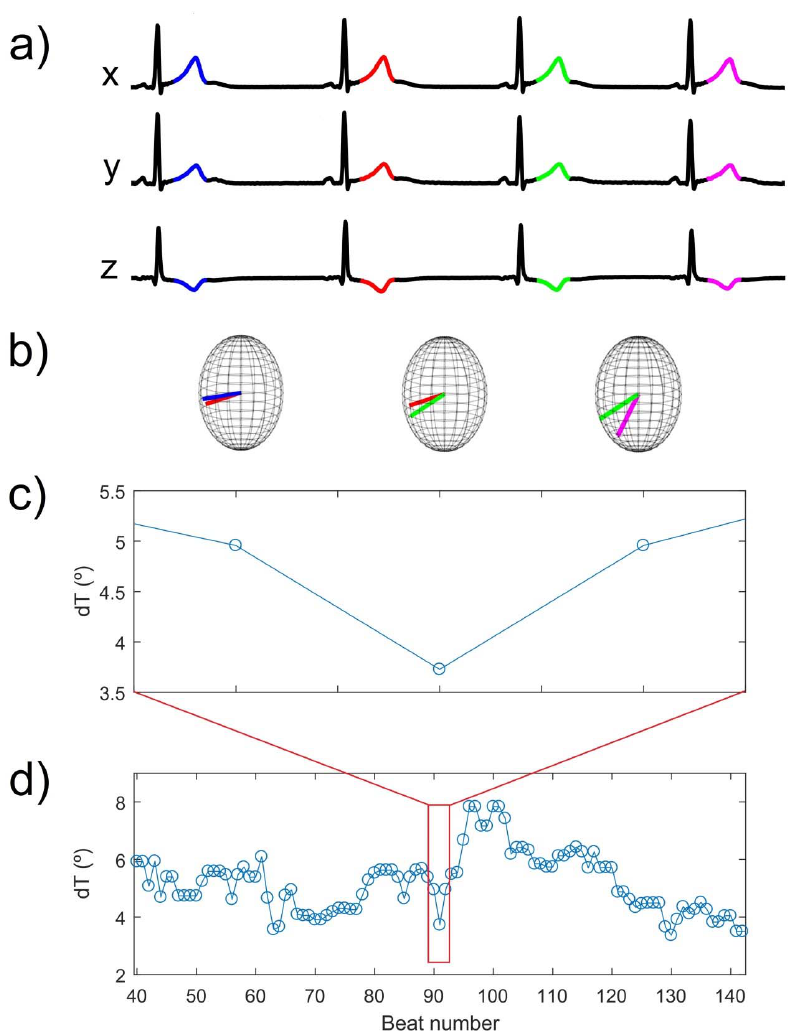
Figure 1. Computation of dT from an ECG in the Frank lead configuration. ( a ) T ‐ waves from four consecutive heart beats. ( b ) Pairs of T ‐ wave vectors from consecutive beats are illustrated in three ‐ dimensional spheres. ( c ) Angle dT between the consecutive T ‐ wave vectors shown in panel b. ( d ) Time series of dT for a piece of an ECG recording.